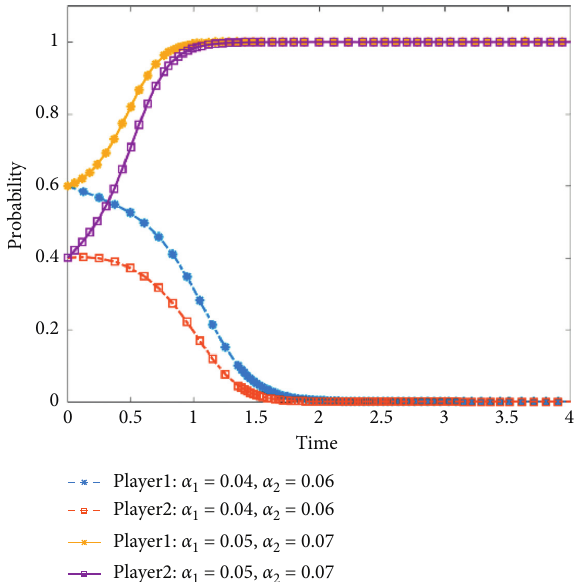
Figure 9: Evolutionary game phase diagram of the system (when α and α improve). 2